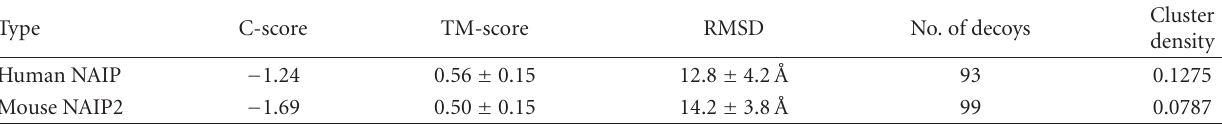
Table 3: The prediction model